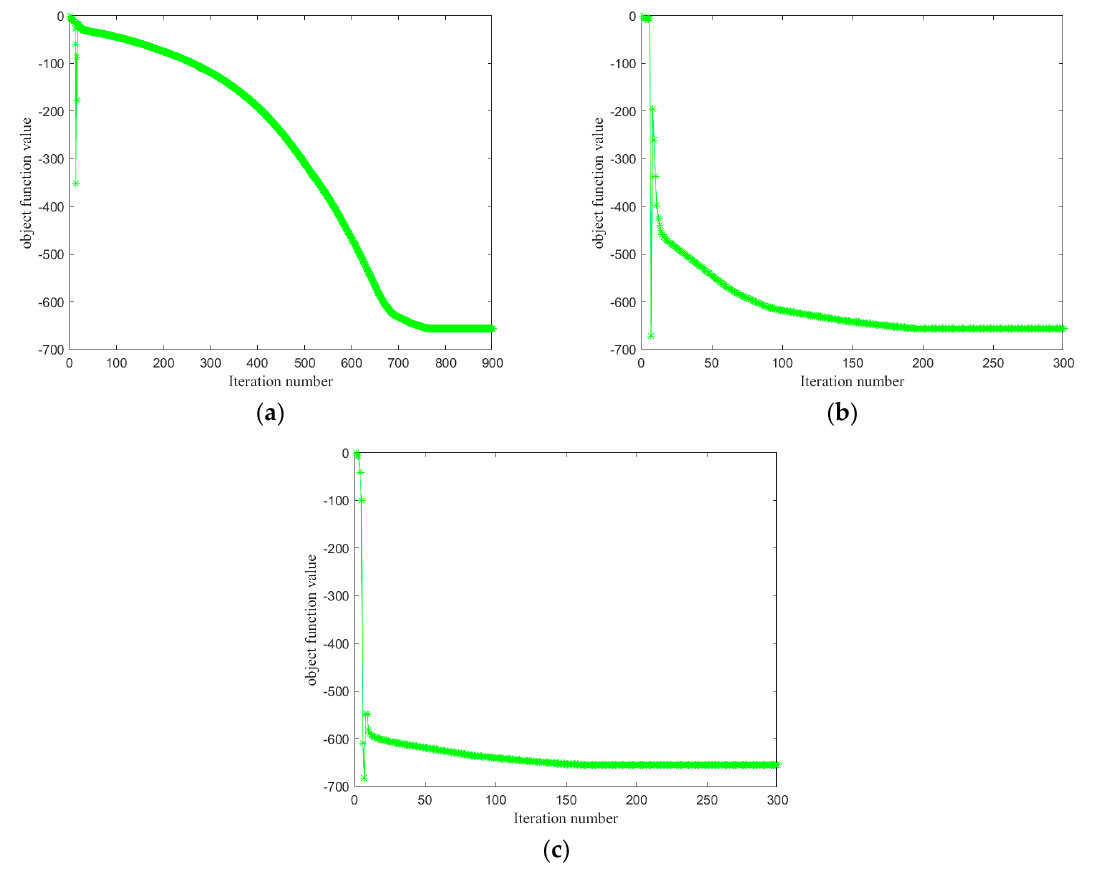
Figure 5. The convergence of JFSSS-HFT under different p. ( a ) The convergence of JFSSS-HFT under p = 1.2. ( b ) The convergence of JFSSS-HFT under p = 1.5. ( c ) The convergence of JFSSS-HFT under p = 2.